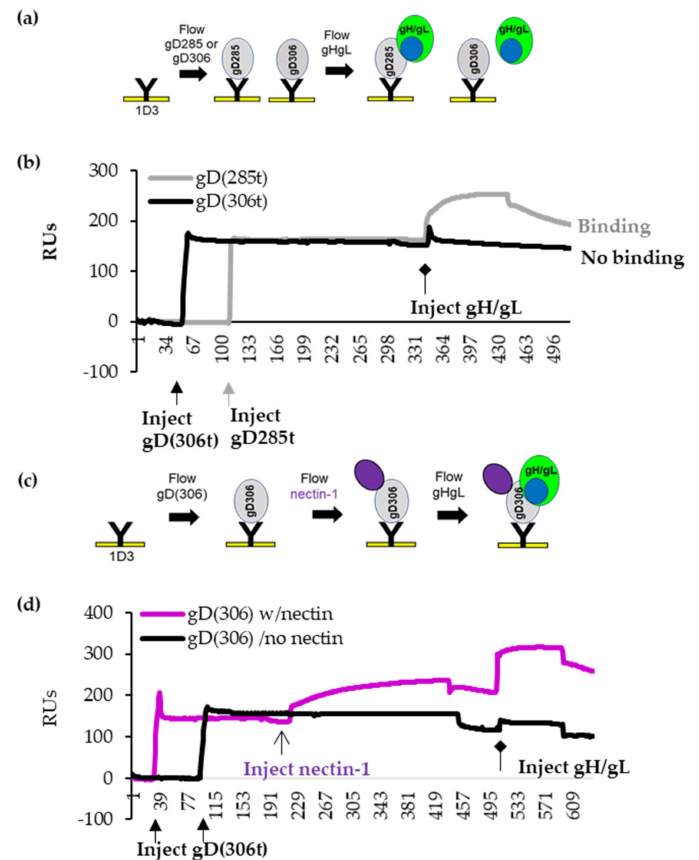
Figure 2. Binding of gHgL to gD by SPR. ( a ). Diagram outlining the SPR protocol. ( b ) . 1D3 (anti-gD Mab) was covalently coupled to a CM5 biosensor chip. An equal amount of gD 285t (gray) and gD 306t (black) were immobilized to different spots on the Biacore chip. Soluble gD 306t or gD 285t and gH/gL were sequentially injected (injection start indicated by diamond arrow). An increase in response units (RUs) after injection indicates binding. gH/gL binds to gD 285t only (black curve). No gH/gL binding was observed for gD 306t (gray curve). x axis, time (seconds). y axis, resonant units (RU). ( c ) Diagram of the SPR protocol for sequential injections of gD 306t and nectin-1, followed by injection of soluble gH/gL. ( d ) gD306 was attached to two flow cells on the biosensor chip via 1D3 Mab. Nectin-1 was flowed over cell 1 only. Flow cell 2 did not receive nectin. gH/gL was flowed over both flow cells. In the absence of nectin-1, gD 306t does not bind gH/gL (black curves). Pre-binding of nectin-1 to gD 306t induced conformational changes that allow for gH/gL binding (purple). Experiments were performed a minimum of three